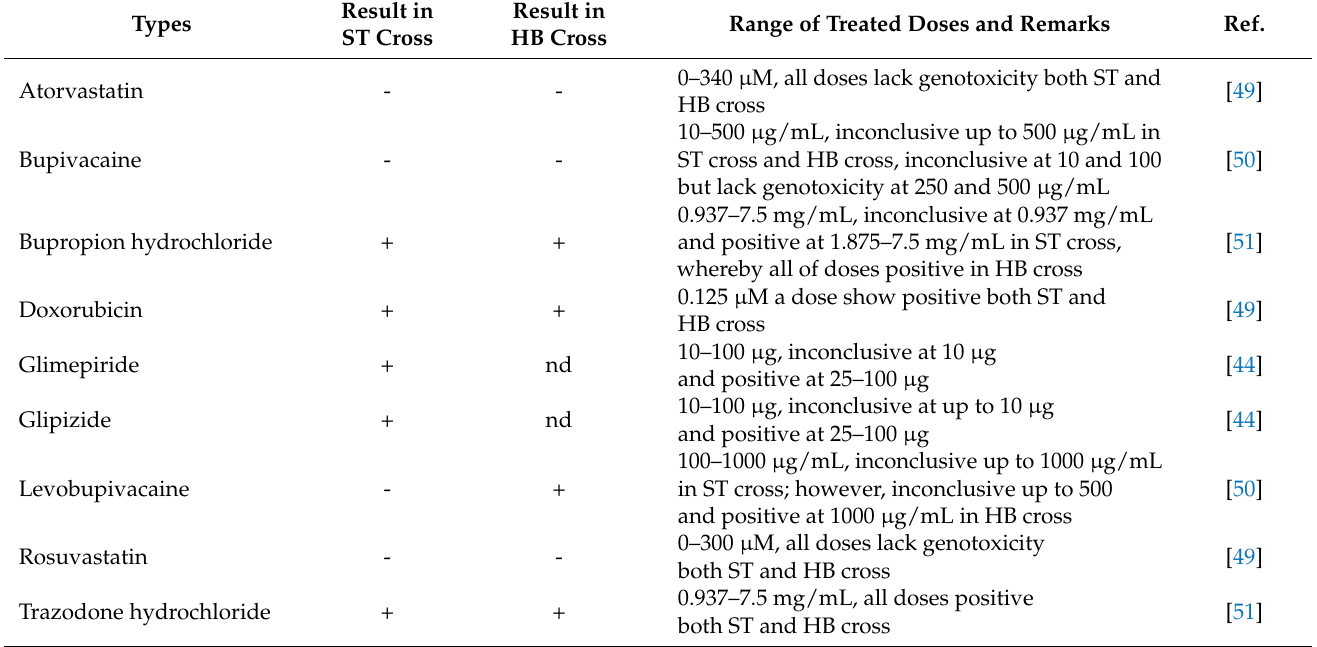
Table 2. Applications of SMART for testing some